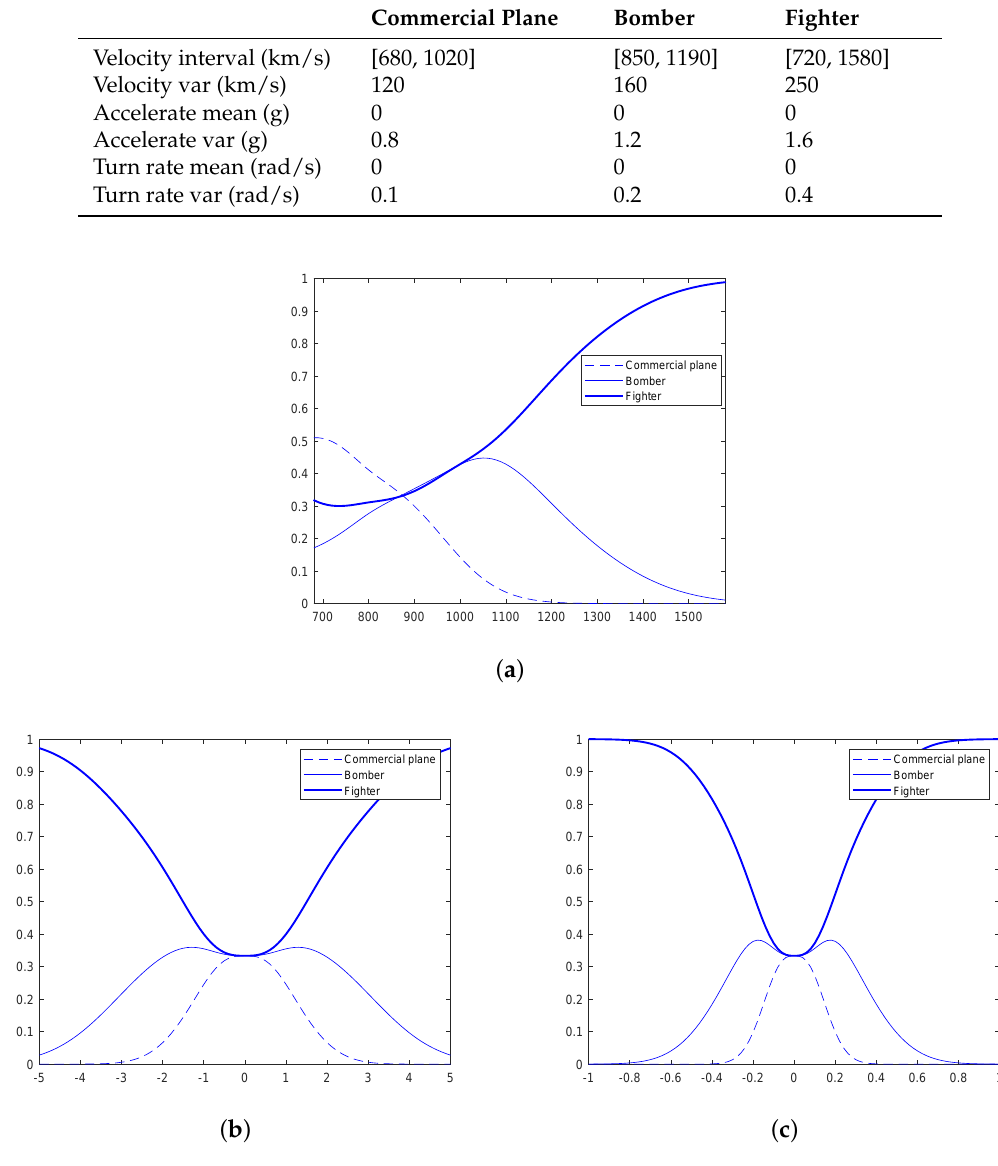
Figure 3. Prior pignistic class probabilities; ( a ) pignistic class probabilities for velocity, ( b ) pignistic class probabilities for acceleration, ( c ) pignistic class probabilities for turn